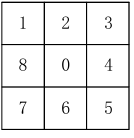
Figure 4. Schematic of the eight neighborhood.